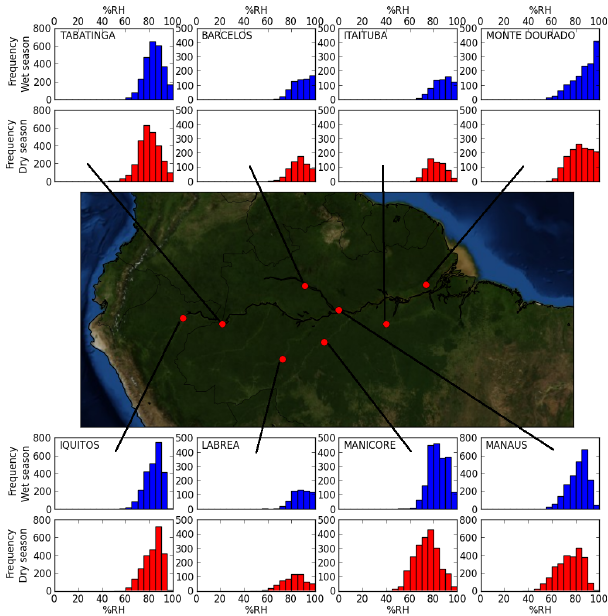
Figure 9. Frequency distributions of RH for the wet season (December–March, shown in blue) and the dry season (June– September, shown in red) at eight ground-based stations in the Amazon Basin. For the stations, hourly RH values (calculated from measured temperature and dew point) were retrieved from NOAA’s National Climatic Data Center (http://www.ncdc.noaa.gov/) for the years from 2004 to 2014. All data shown are 12h